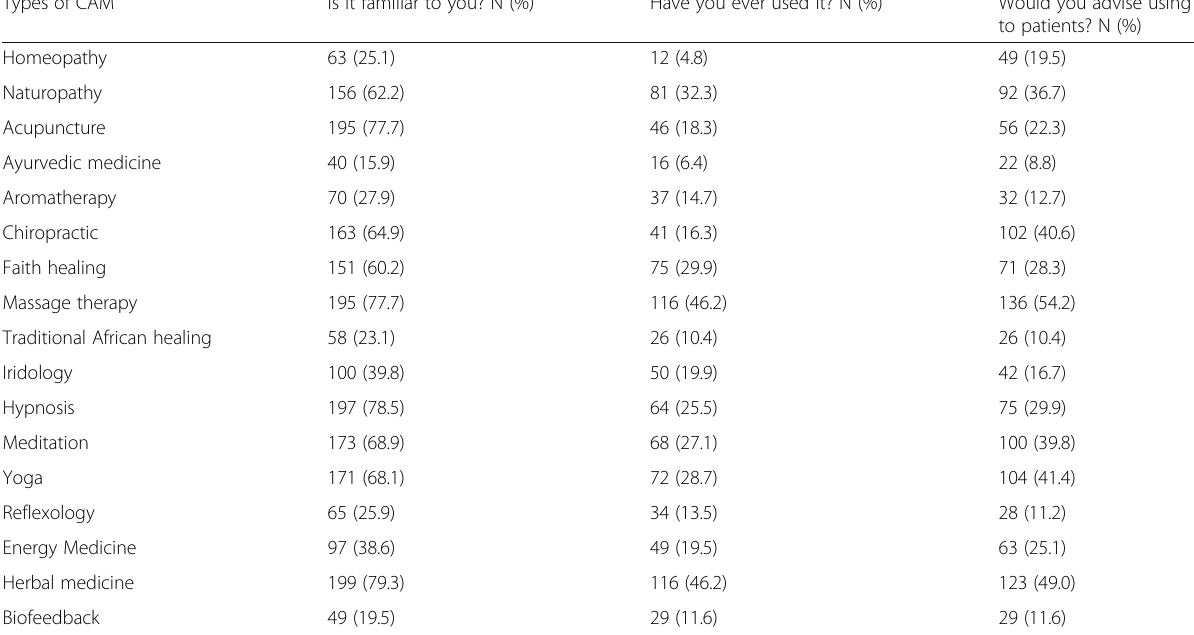
Table 4 Types of complementary and alternative medicine (CAM) and participants ’ knowledge and attitude regarding them